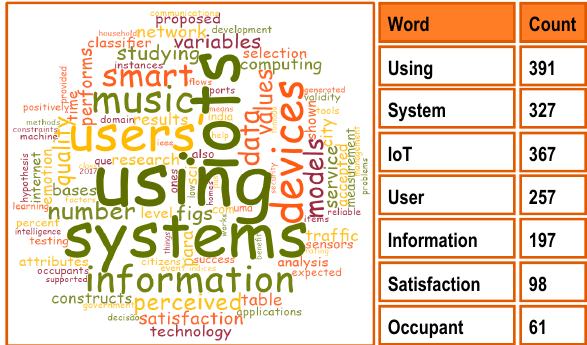
Figure 7. The word cloud based on the frequency of exact words, and the frequency of words within Group 1 of the AISH database considering word stems.